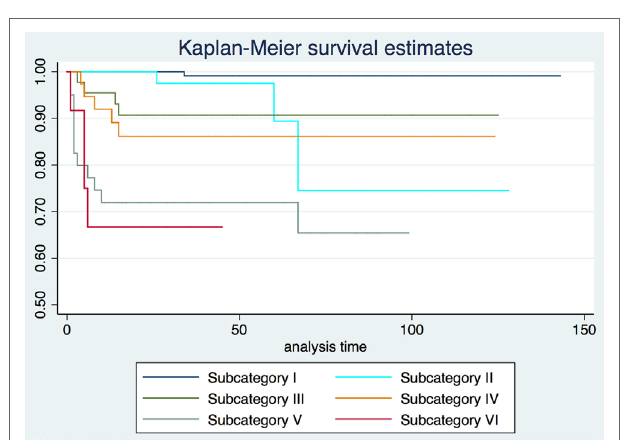
FigUre 2 | Local control with laser alone Kaplan–Meier curves for each subcategory.